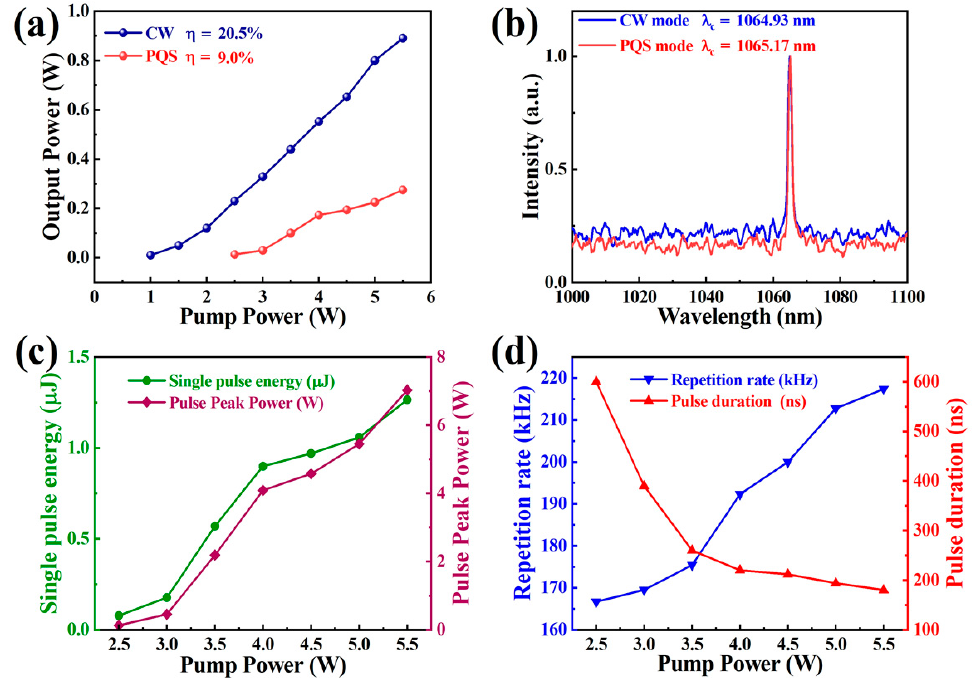
Figure 5. ( a ) Average output power of CW and PQS Nd: YAG lasers versus pump power; ( b ) output spectra of the CW and PQS Nd: YAG lasers; ( c ) single pulse energy and pulse peak power versus pump power; ( d ) pulse repetition rate and pulse duration versus pump power.